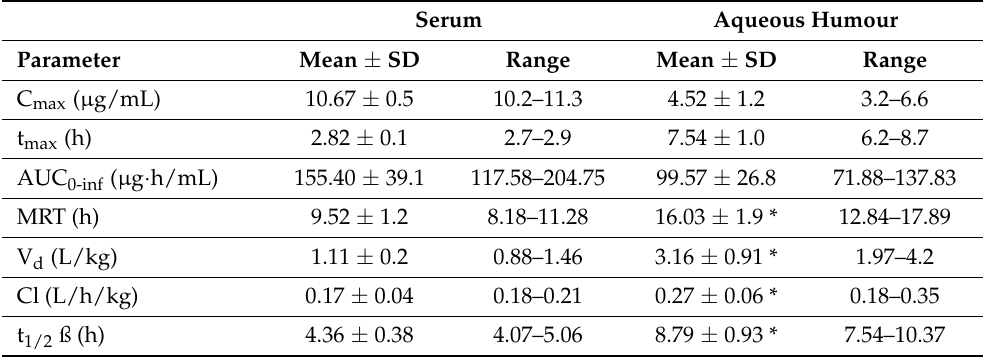
Table 1. Pharmacokinetic parameters for fluoroquinolones in serum and aqueous humour after a single intramuscular application of 25 mg/kg body weight.